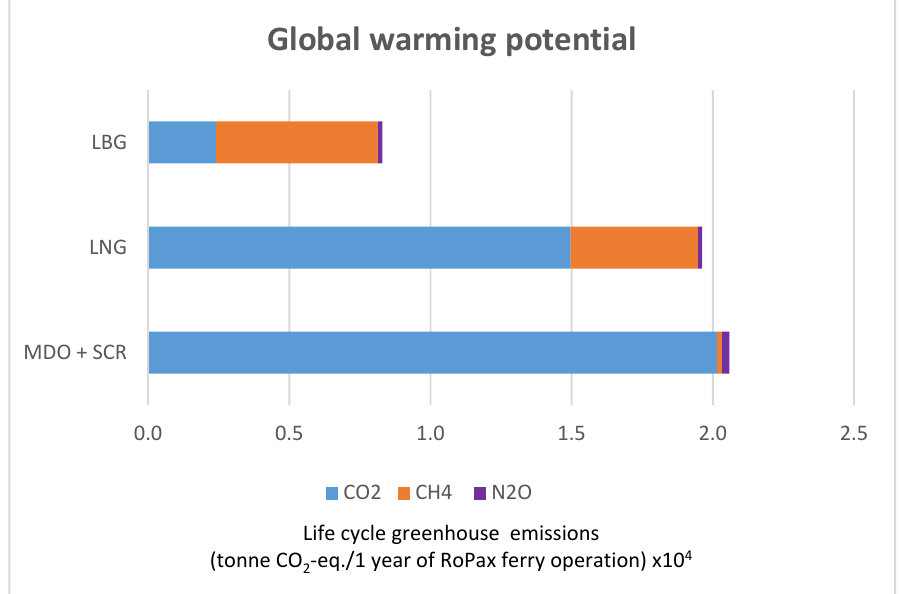
Figure 3. Life cycle GHG emissions for the compared alternatives divided into the different contributing emissions.